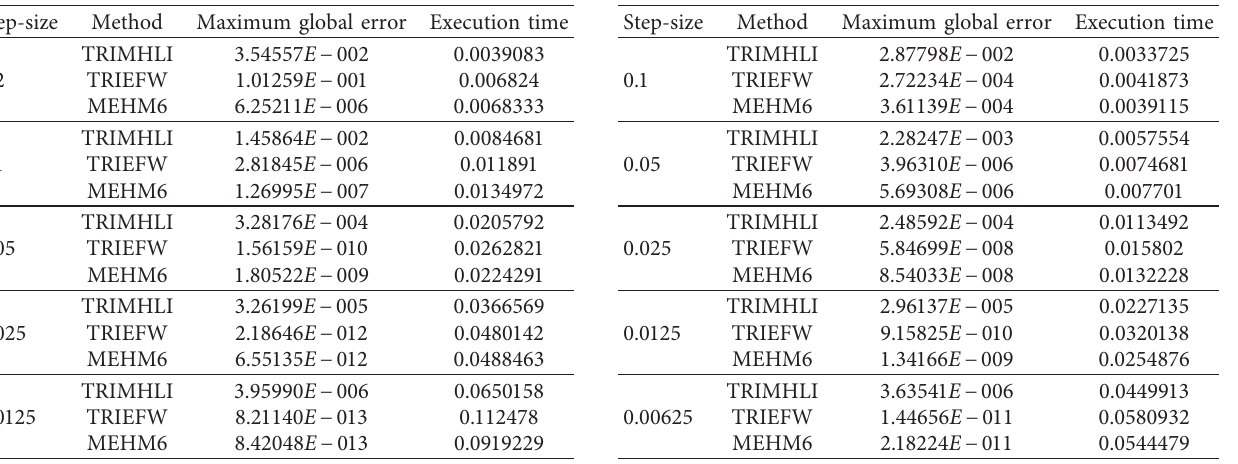
Table 4: Numerical results for Problem 4.